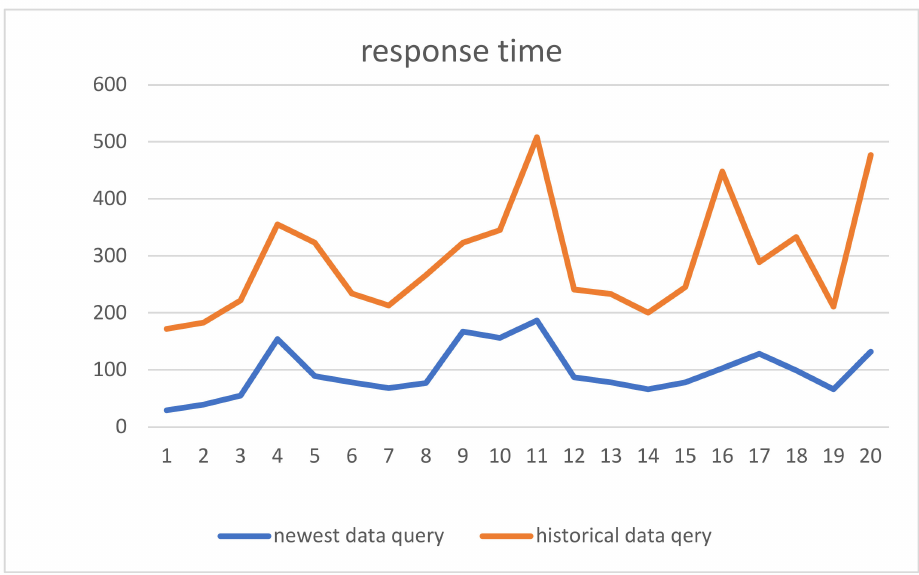
Figure 17. The response time of newest and historical data query (2400 clients’ connections).